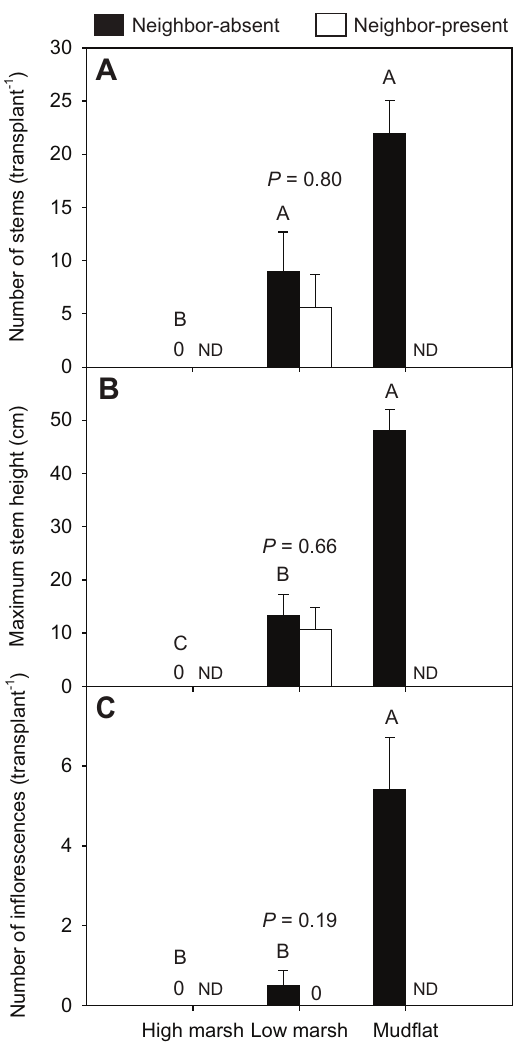
Figure 2. Cordgrass performance in different zones at the salt marsh site in 2009. (A) number of stems (B) maximum plant height and (C) number of inflorescences. Data are means + 1SE. ND indicates no data. Bars sharing a capital letter were not significantly different from one another (nonparametric multiple comparisons, Steel-test). P - values from ANOVAs or Wilcoxon tests investigating the effect of neighbors are indicated above the bar group for low marsh transplants.